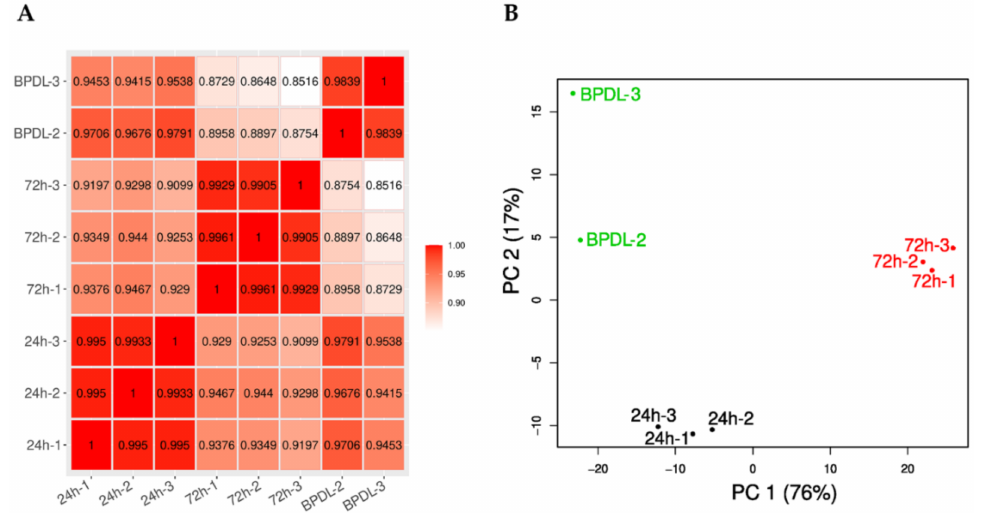
Figure 3. Inter- and intragroup variability of gene expression. ( A ) Pearson correlation of log2 transformed read counts. BPDL-2 and BPDL-3 exhibit lower correlation than the two other conditions (24 and 72 hpi). ( B ) Gene expression principal component analysis (first two dimensions). Replicates for untreated samples (24 and 72 hpi) exhibit lower within-group distances as compared to the two BPDL-treated